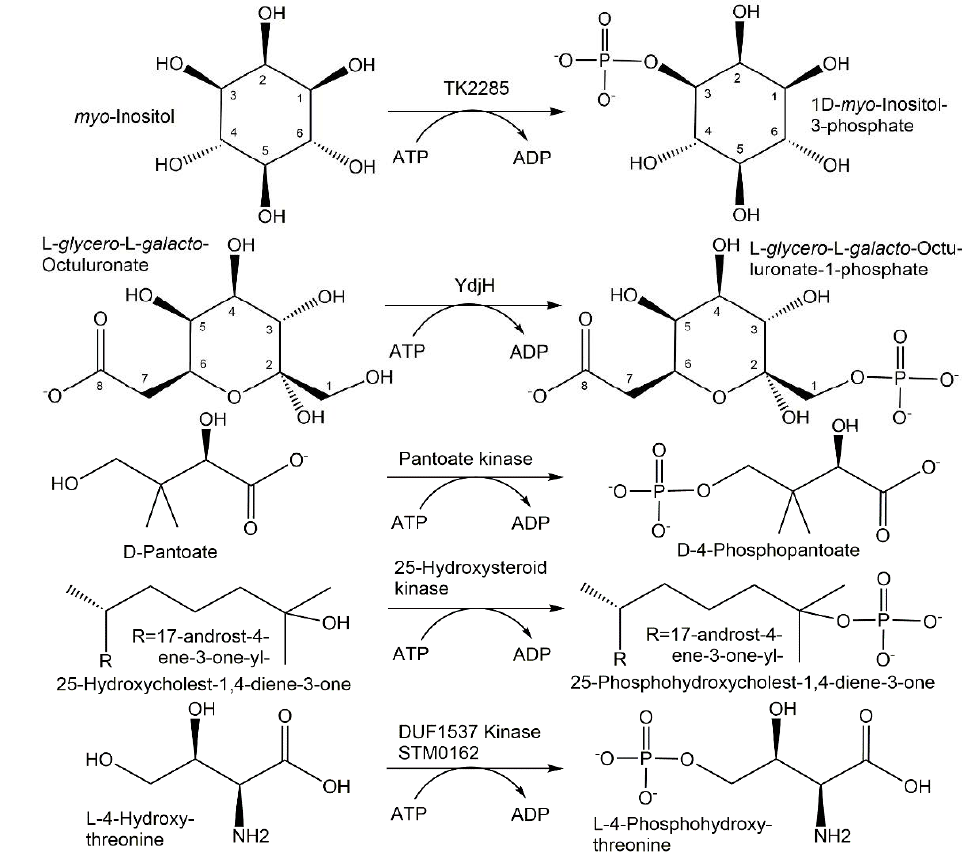
Figure 7. Novel phosphotransferases for phosphorylation reactions.